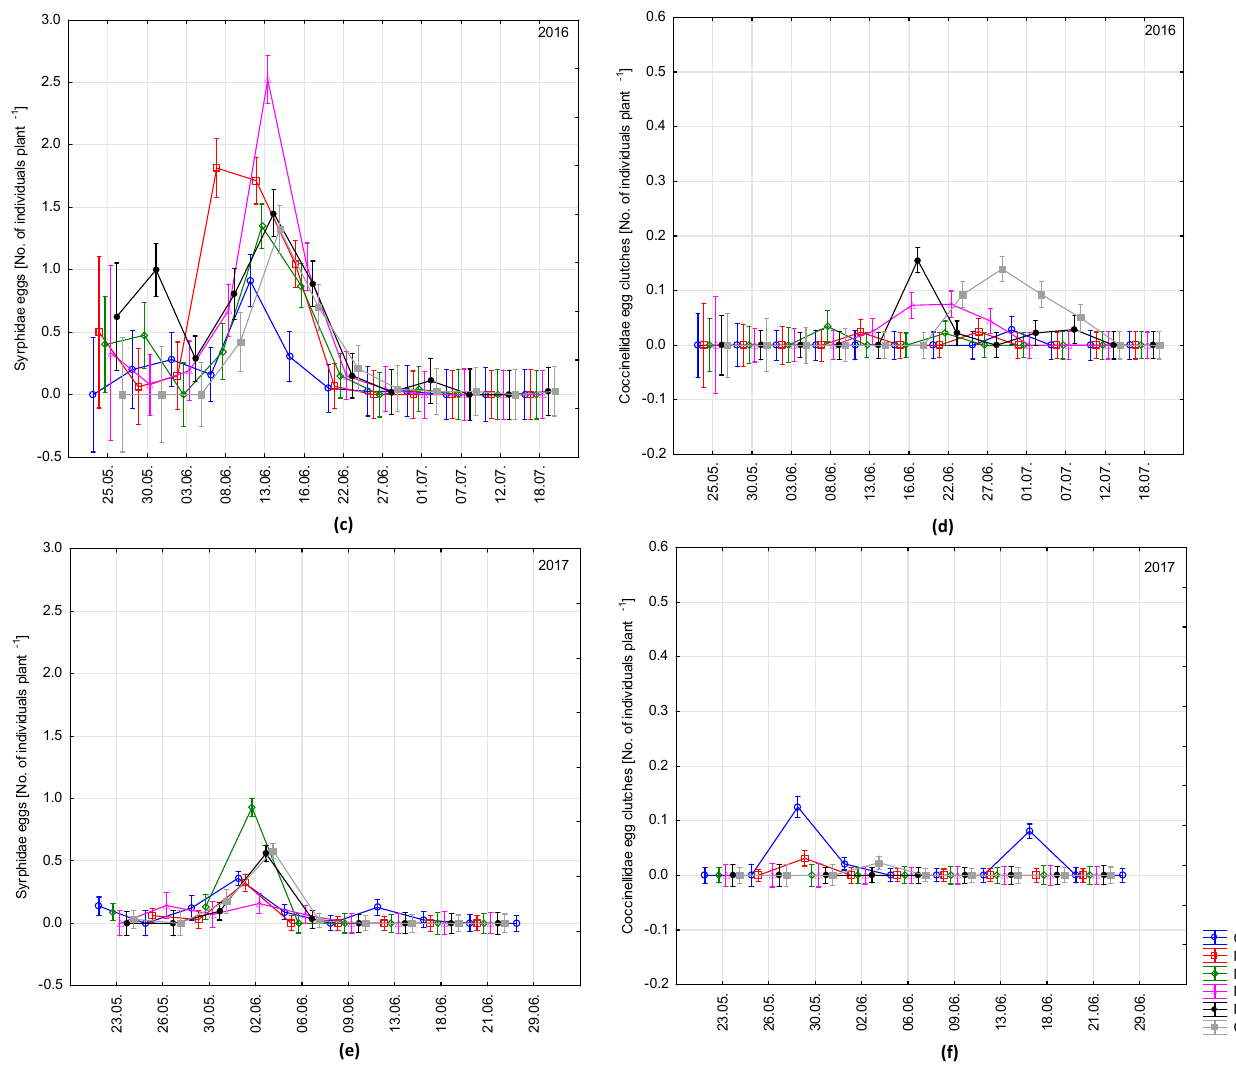
Figure 2. Mean numbers of Syrphidae eggs ( a , c , e ) and Coccinellidae egg clutches ( b , d , f ) per one broad beans plant at individual days of observations in the 2015 ( a , b ), 2016 ( c , d ), and 2017 ( e , f ) seasons. Vertical bars mean ± SE. Symbols as in Figure 1. The scale for Figure 2a different from Figure 2c,e.